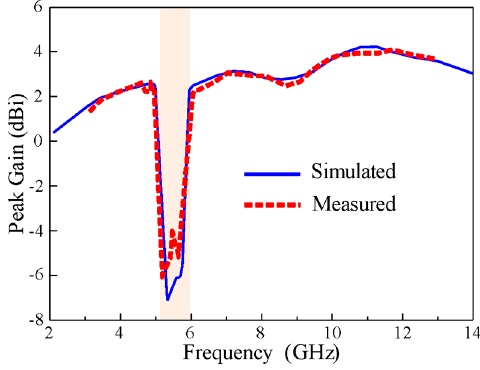
Figure 15. The measured and simulated gain of the proposed antenna.